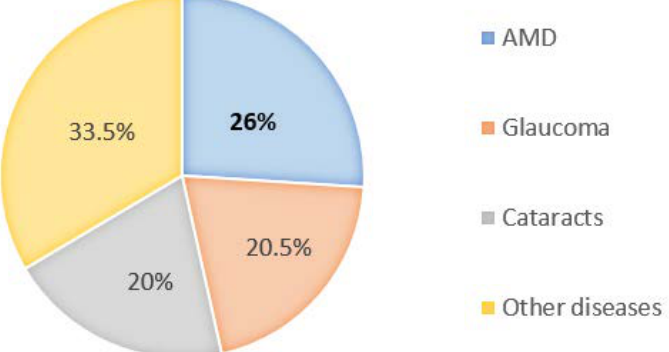
Figure 2. Incidence in Europe of the various eye diseases in people over 65 years of age [7].